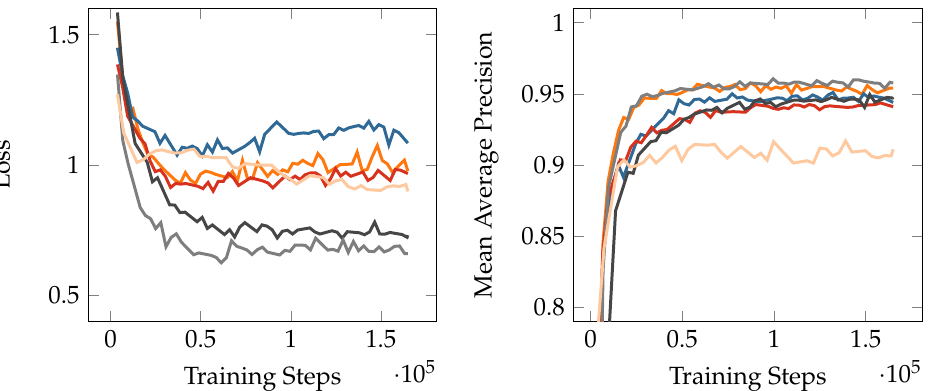
Figure 10. Loss and Mean Average Precision for each experiment over 165,000 training